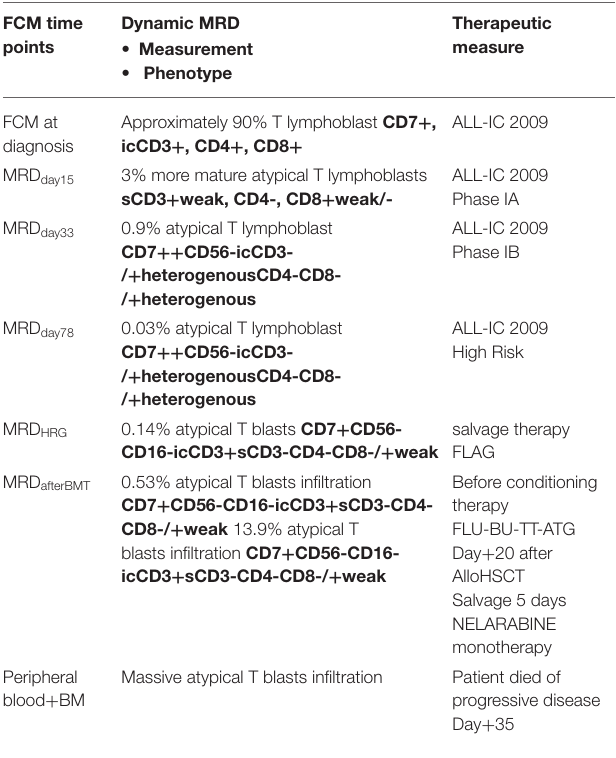
TABLE 1 | Clonal evolution at multiple time points during the disease